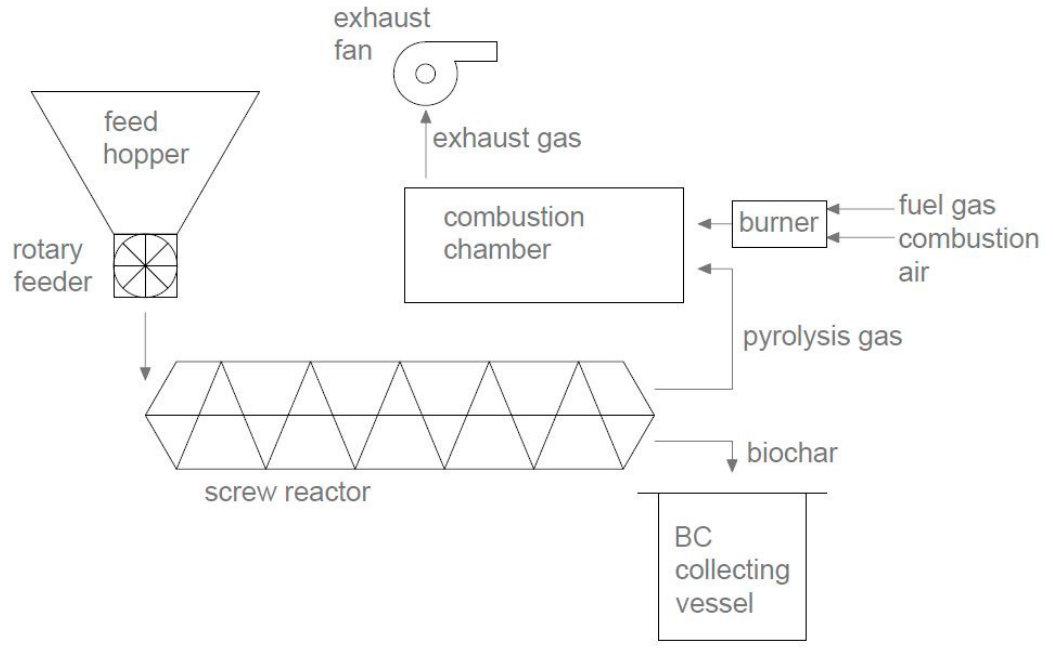
Figure 2. Schematic sketch of the screw reactor for the pyrolysis of sunflower husks (SFH).